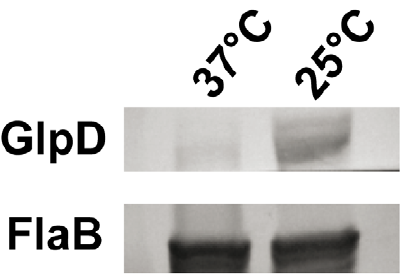
Figure 4. B. burgdorferi GlpD expression is temperature dependent. Whole cell lysates of B. burgdorferi B31-A3 grown at 37 u C and 25 u C were analyzed by immunoblotting. FlaB levels were determined as a